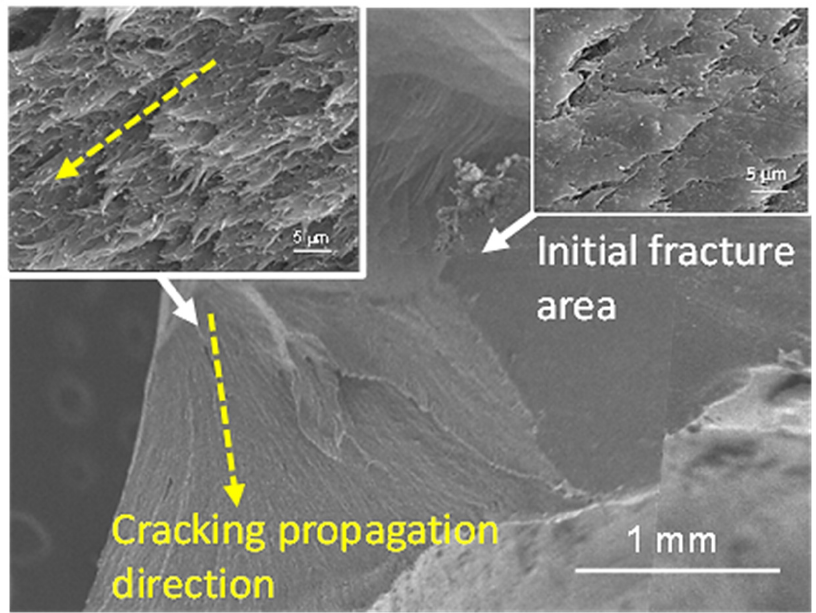
Figure 8. SEM microscopic observation of fracture morphology of 20% TiO 2 -containing PEEK crown after compression test (yellow arrow indicates the direction of cracking propagation).